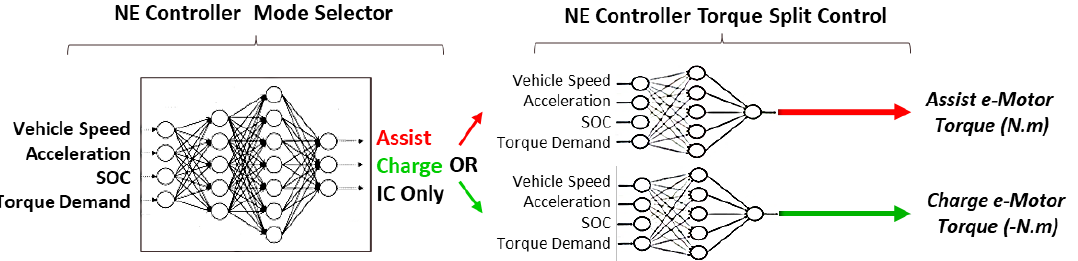
Figure 4. Example HEV Neuroevolved Controller base architecture with three inter-connected neural networks running concurrently. The Assist and Charge mode are mutually exclusive when selected. They directly output the demand Torque to the e-motor control module.